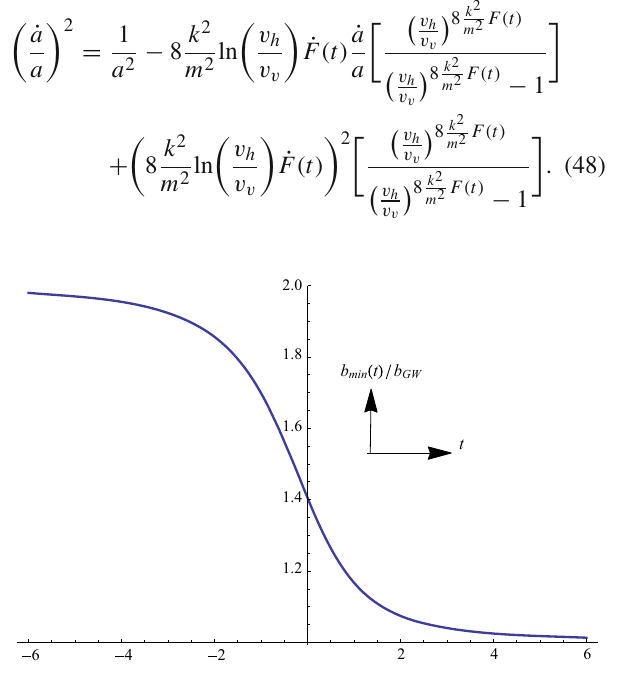
Fig. 2 b min ( t ) vs. t for B = 1 and D = 0 . 5